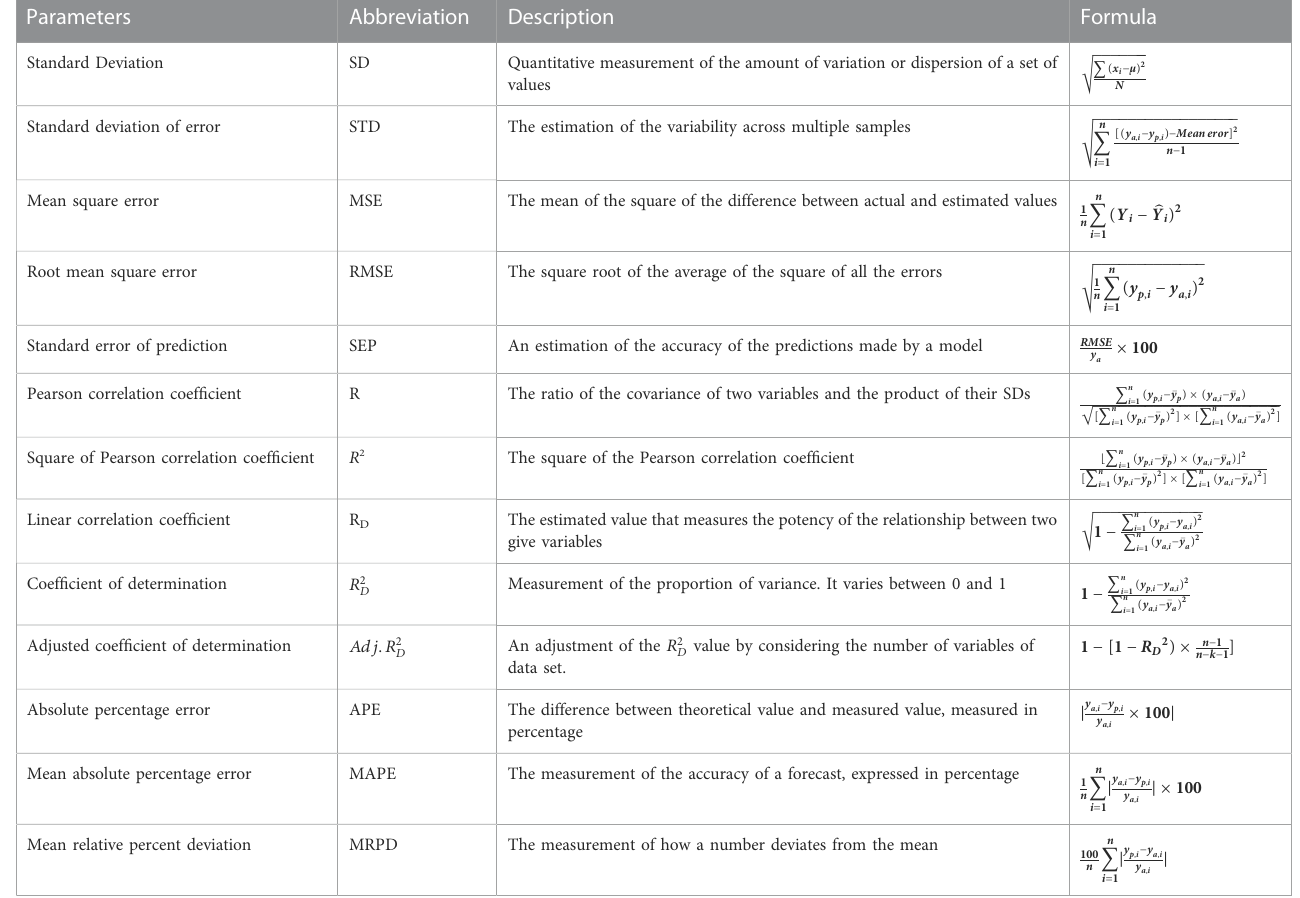
TABLE 5 Statistical parameters commonly used in ANN models (Khair et al., 2017; Ofoefule et al., 2019; Galvan et al., 2020).